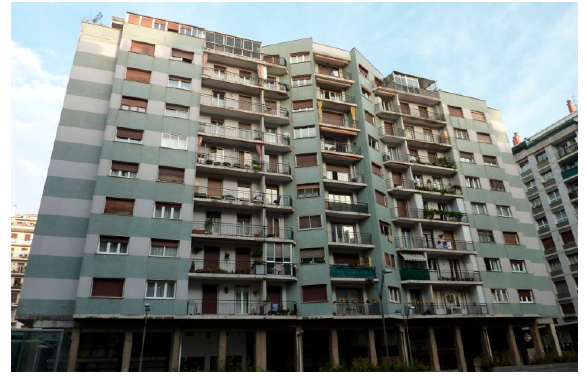
Figure 2. Picture of the case study